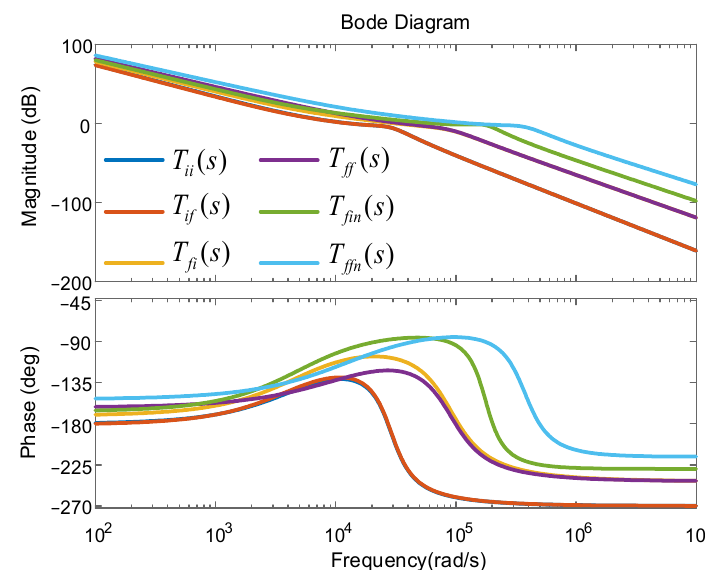
Figure 10. Bode plots of the loop gains of the GCIs.